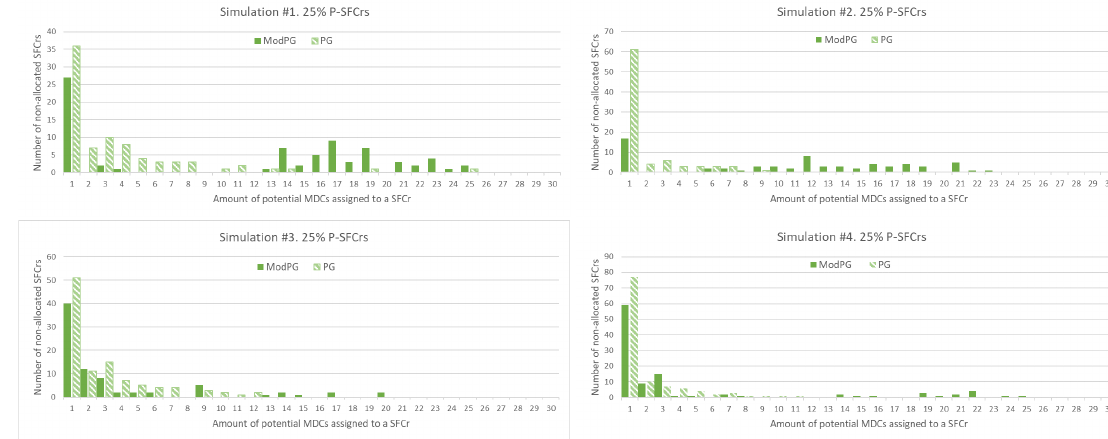
Figure 6. Detailed analysis of non-allocated SFCrs. Sets of 600 SFCrs with 25% P-SFCrs. Scenario 2: CPU and memory capacity of MDCs set to